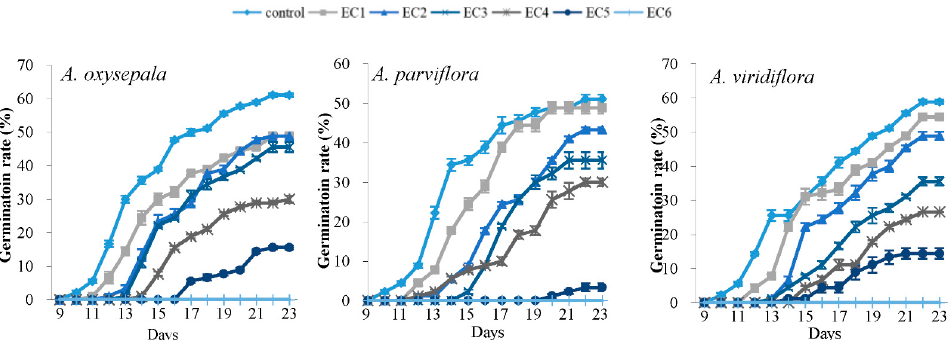
Figure 2. Average daily germination percentage of three Aquilegia seeds. Control, EC 1, EC 2, EC 3, EC 4, EC 5, and EC 6 correspond to the respective treatments of irrigation solution: distilled water